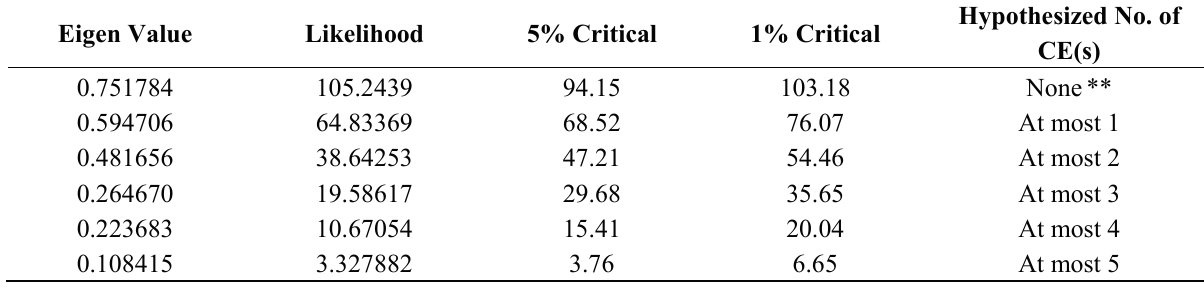
Table 3. Johansen co-integration result.